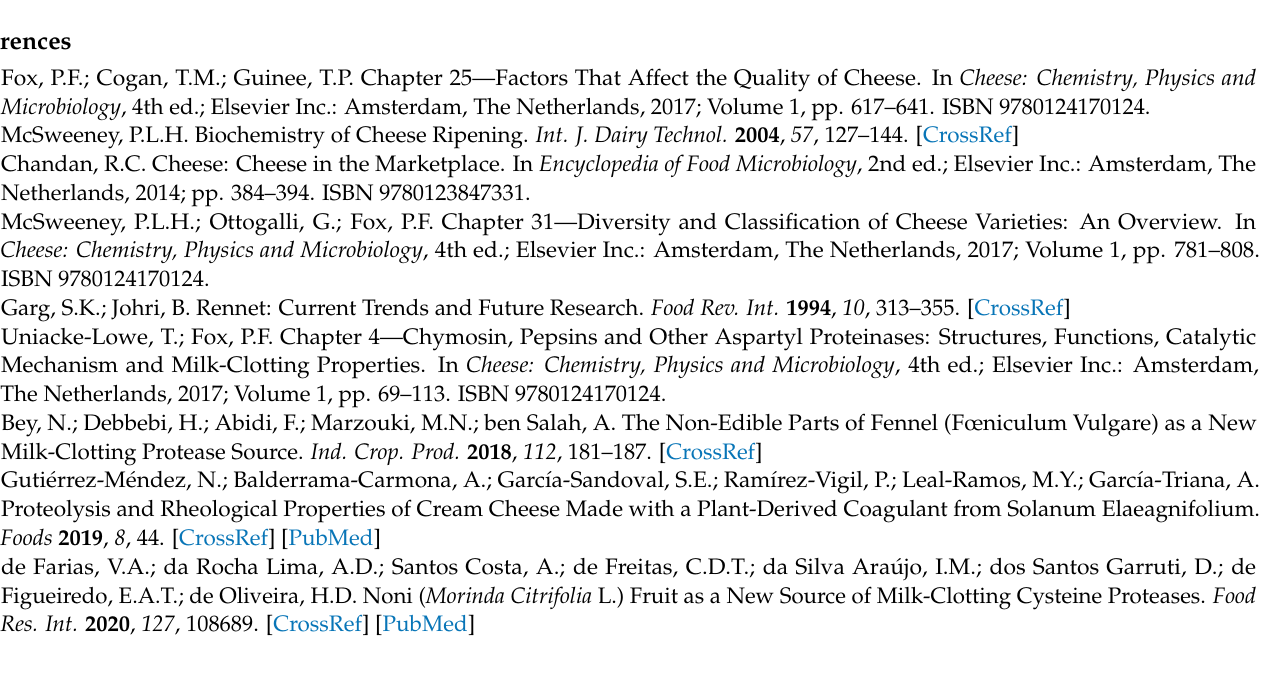
Figure S3: Alpha diversity plots of Pielou’s evenness and Shannon indices for mycobiota based on the sample matrices (Caciofiore cheeses, raw milks, and thistle